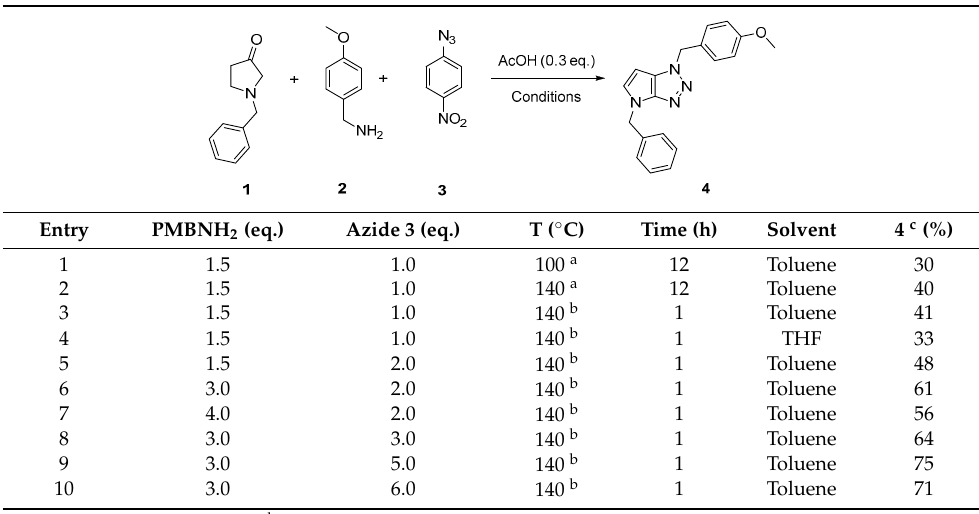
Table 1. Optimization of conditions for the formation of 4 .